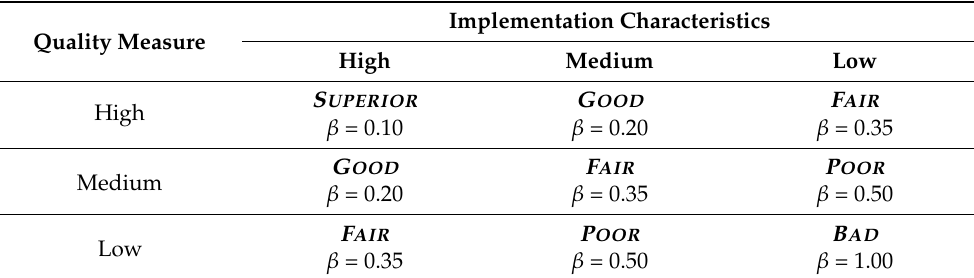
Table 1. Assessment matrix for the implementation application of a quality measure for a considered issue or component. Each of the assignments of High, Medium and Low is described by text specific to the component under discussion. A value of 0.10 is taken as the very reliable (little uncertainty), and 1 is not reliable (complete uncertainty). This Table is the same for all Quality